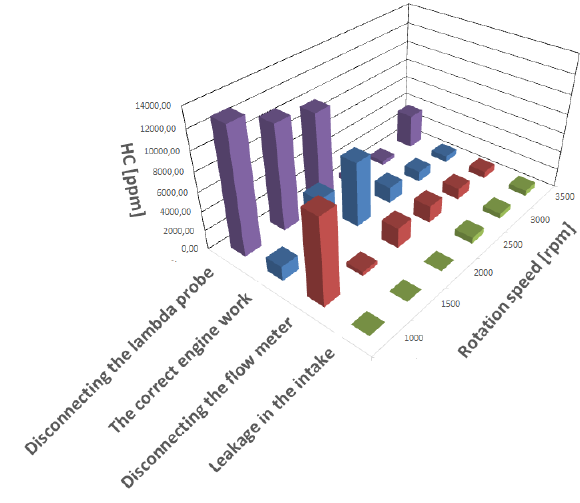
Fig. 11. The content of hydrocarbons in the exhaust gas of a BMW engine fueled with LPG working efficiently and for simulated damage